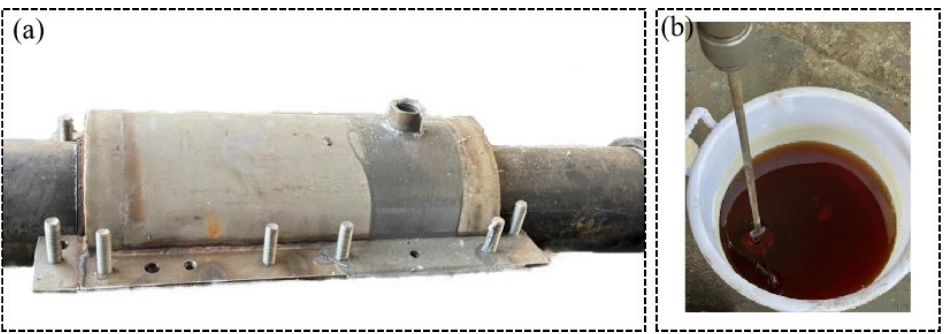
Figure 2. Test materials and setup: ( a ) offshore oil transfer conduit and exterior sleeve construction; ( b ) dispensing condition for plugging agents.